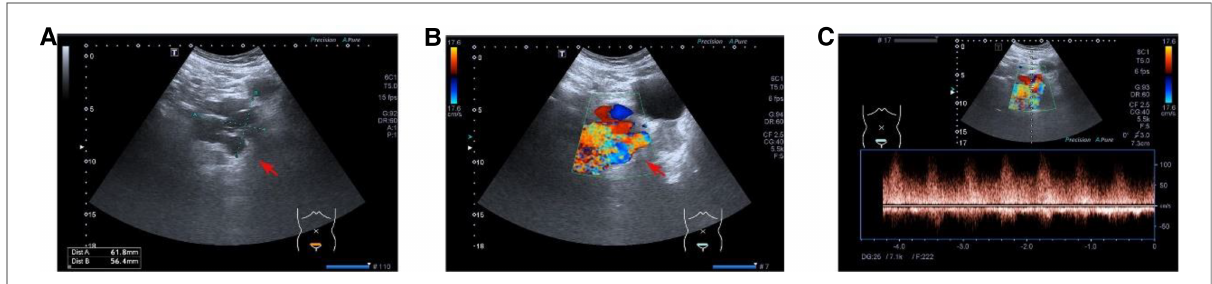
FIGURE 1 ( A ) Multiple tortuous tubular structures within an irregularly shaped anechoic lesion were revealed by B-mode ultrasound. ( B ) Color Doppler fl ow imaging displayed rich colorful blood fl ow signals as a colored mosaic pattern. ( C ) Spectral Doppler showed continuous turbulent fl ow in the systolic and diastolic phases with a high-velocity low-resistance waveform.